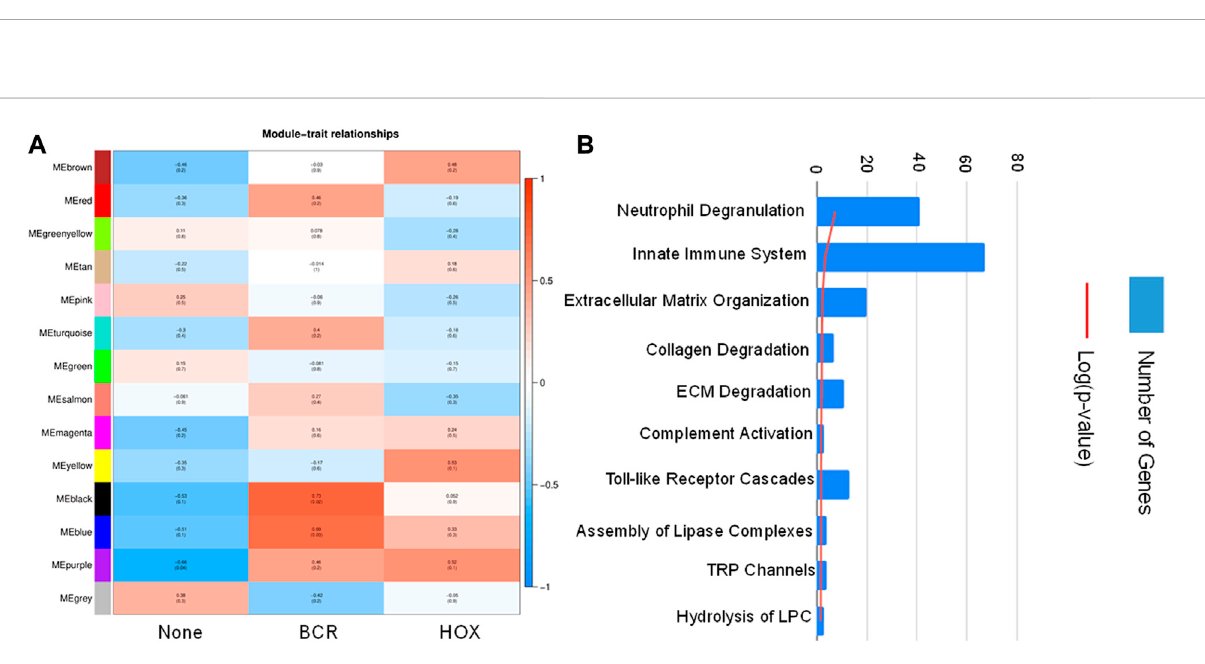
FIGURE 5 (A) Module-trait correlation heatmap using the differentially expressed genes with fusion transcript groups as traits, the red color corresponds to positive correlation and the blue color corresponds to negative correlation. (B) Bar chart showing signi fi cantly enriched pathways obtained using the genes of the “ yellow ” module correlating to the HOX group of samples.